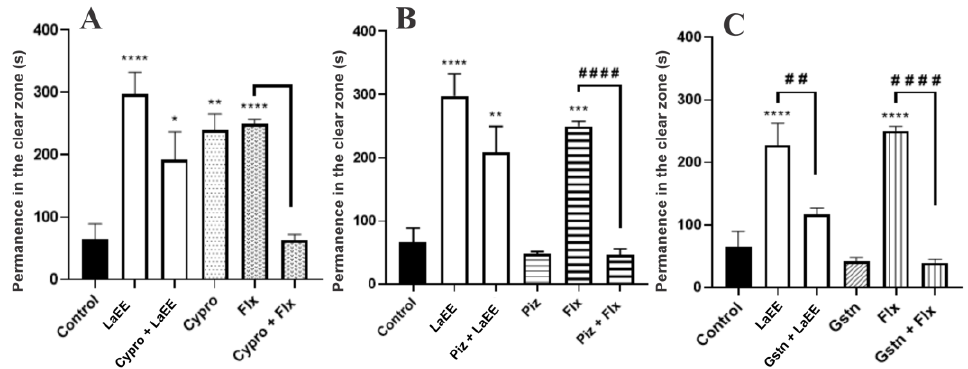
Figure 7. Effects of the pre-treatment with cyproheptadine ( A ), pizotifen ( B ), and granisetron ( C ) in the anxiolytic effect of L. alba ethanolic extract through the light/dark test (0 – 5 min). The values represent the mean ± standard error of the mean of six animals/group; two-way ANOVA followed by Tukey’s test (* p < 0.05, ** p < 0.01, *** p < 0.001, **** p < 0.0001, vs. control; ## p < 0.01, #### p < 0.0001 vs. Flx or Lippia ). LaEE: Lippia alba ethanolic extract; Cypro: cyproheptadine; Piz: pizotifen; Gstn: granisetron; Flx: fluoxetine.